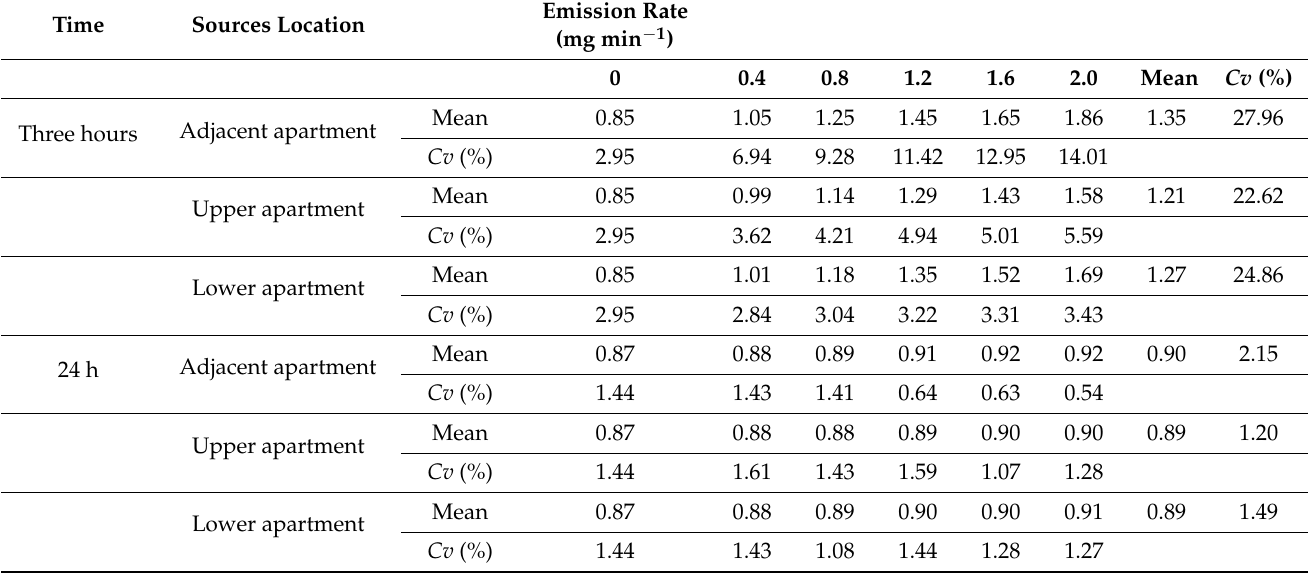
Table 4. Average penetration factor under 4 Pa pressure difference during two periods for four days (8, 9, 12, and 15 September) with five generation rates (0.4; 0.8; 1.2; 1.6; 2 mg min − 1 ). Cv is the coefficient of variation of the